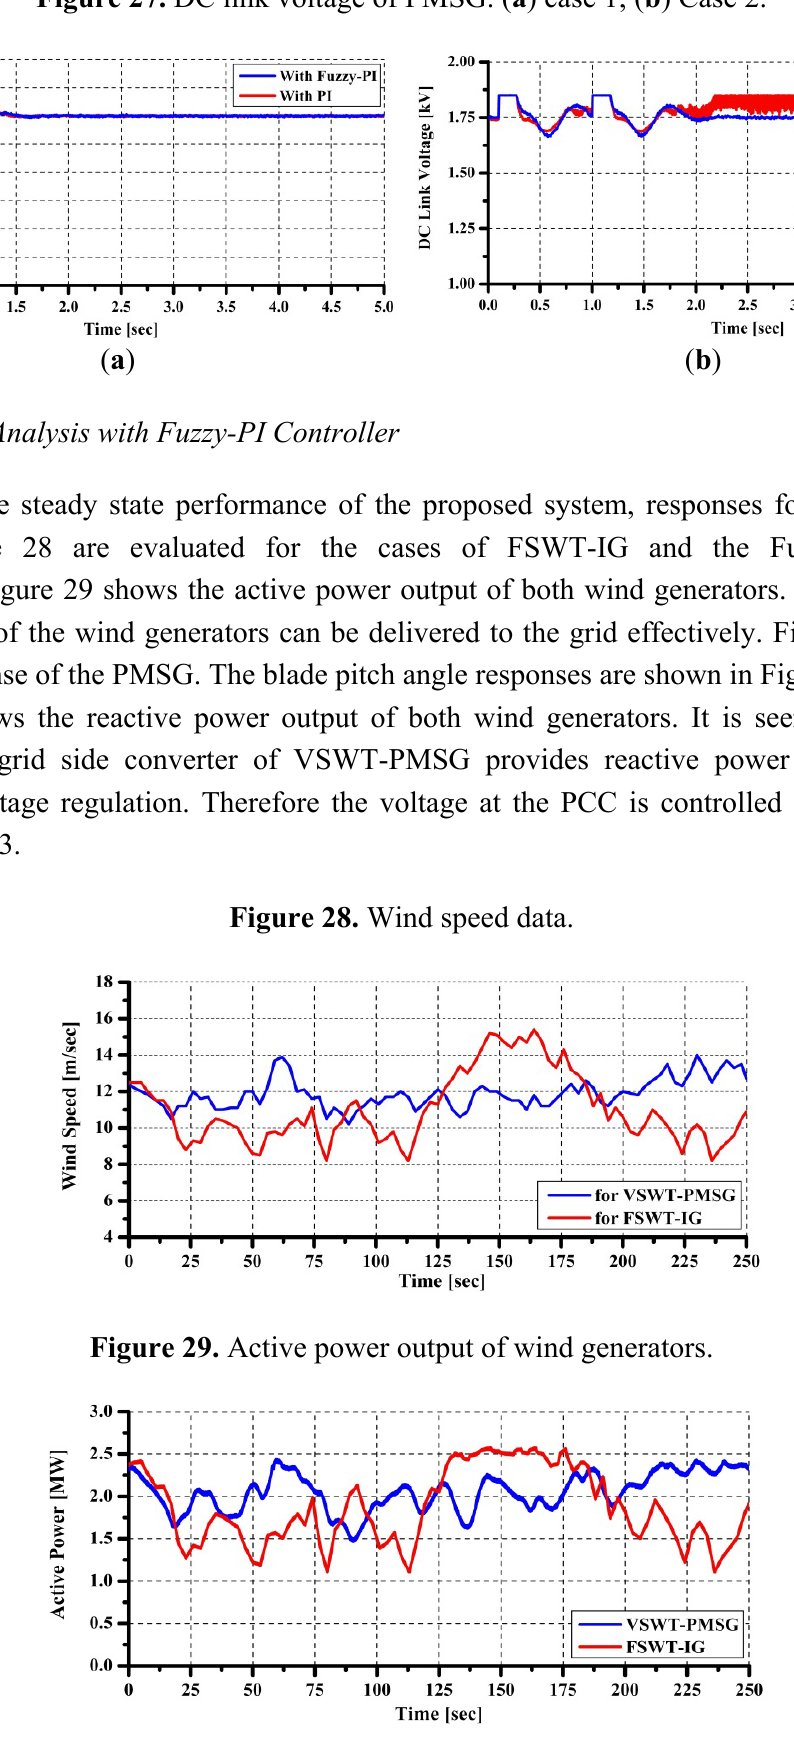
Figure 27. DC link voltage of PMSG. ( a ) case 1; ( b ) Case 2.